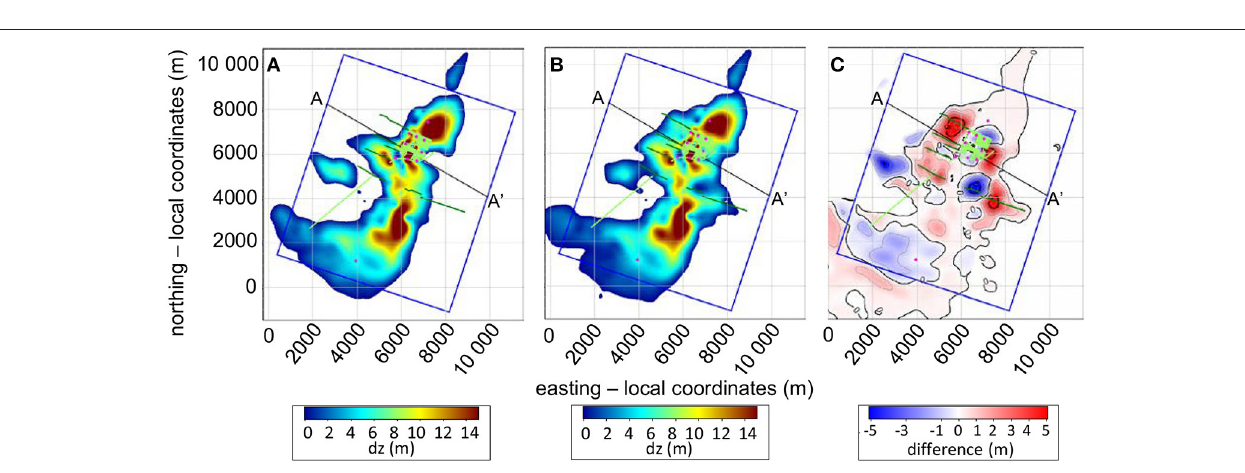
The final map of Esker Sand and Gravel unit thickness is computed by KED on a 10 meter cells fine